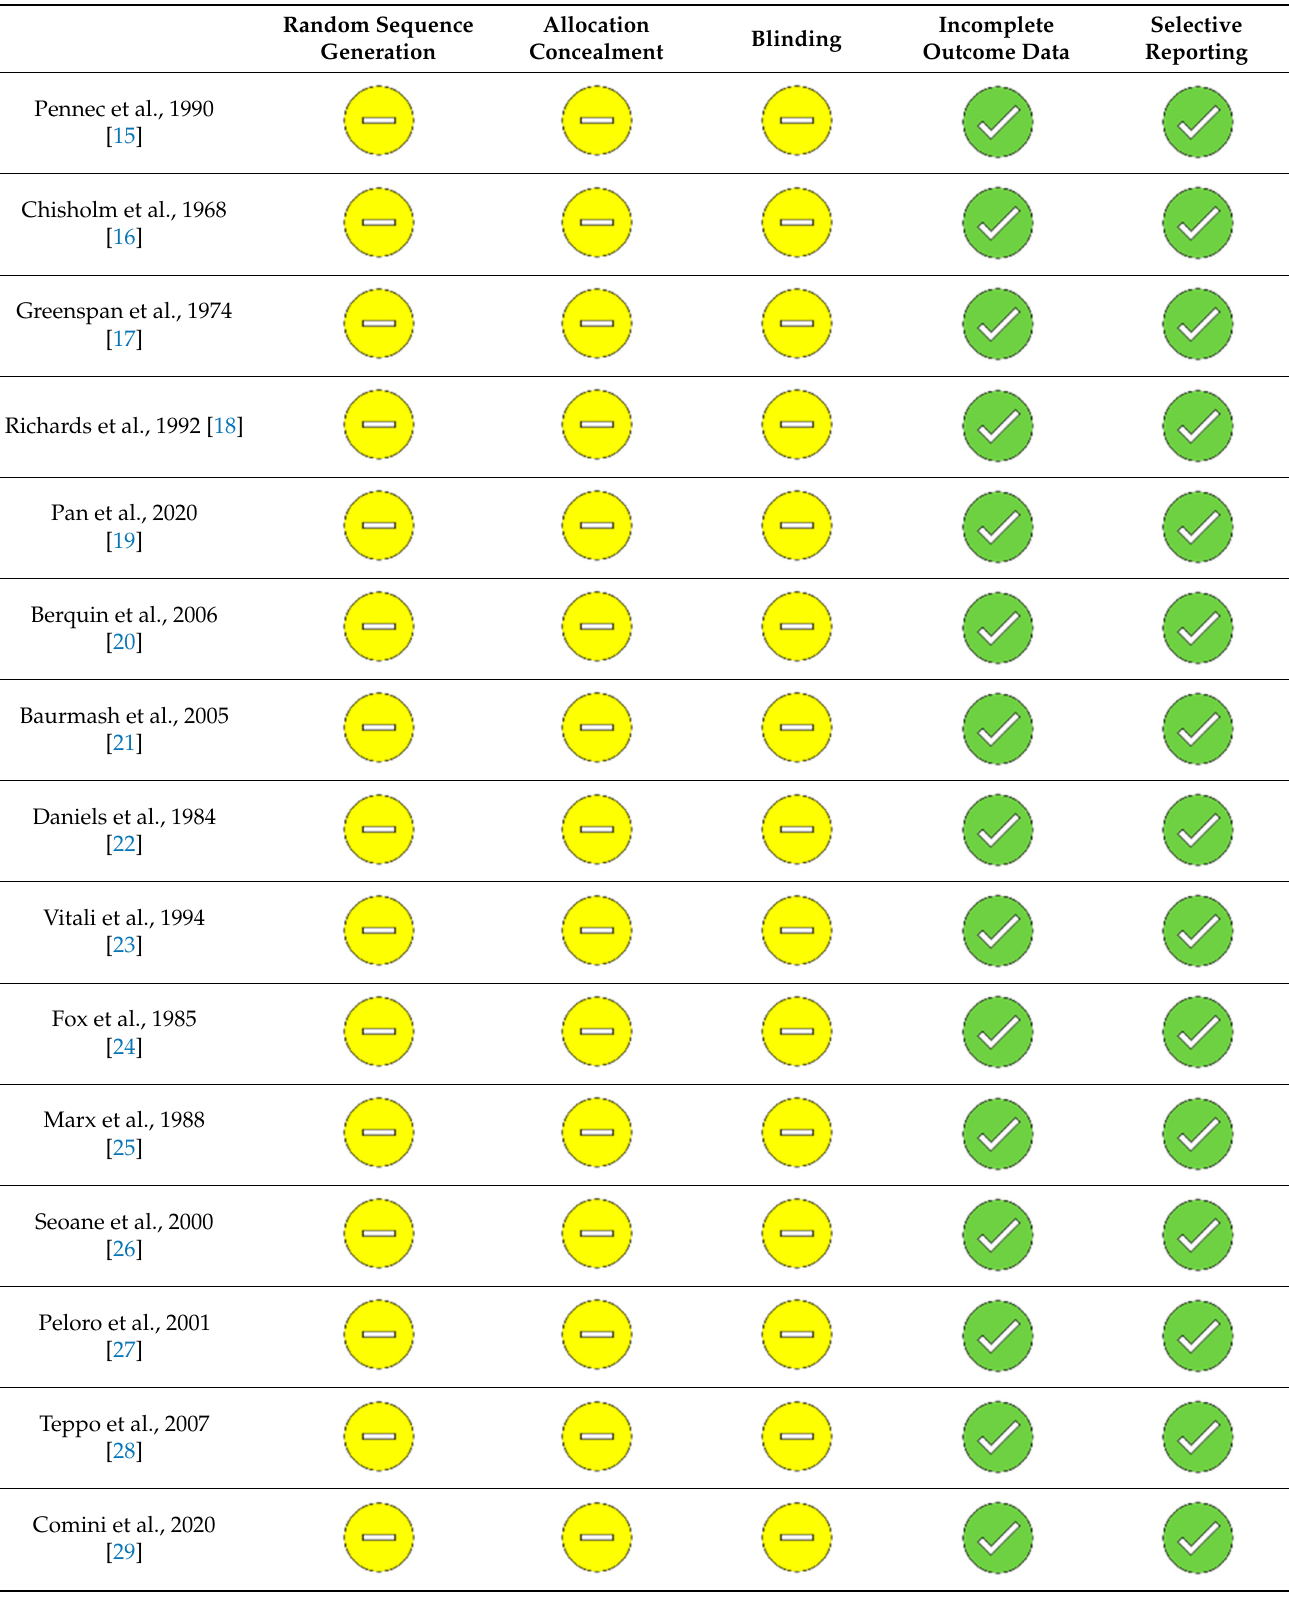
Table 1. Risk of bias of studies is represented by the green symbol, low risk of bias, and the yellow symbol, high risk of bias.